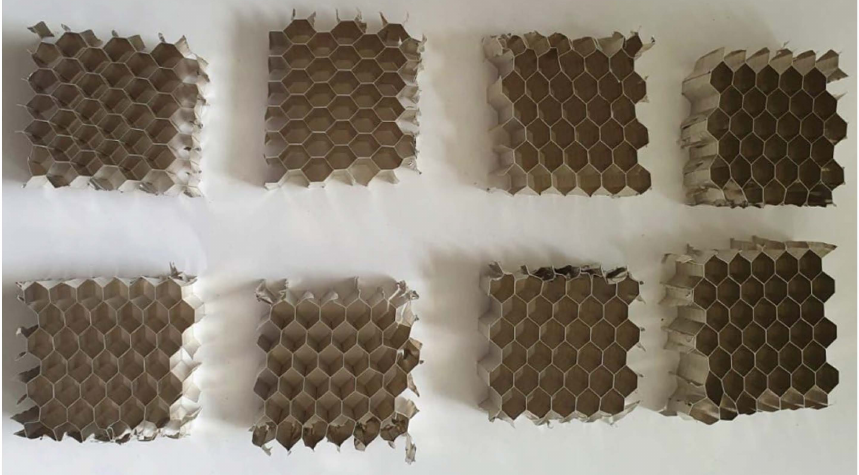
Figure 9. Compression test specimens made from 5052 aluminum